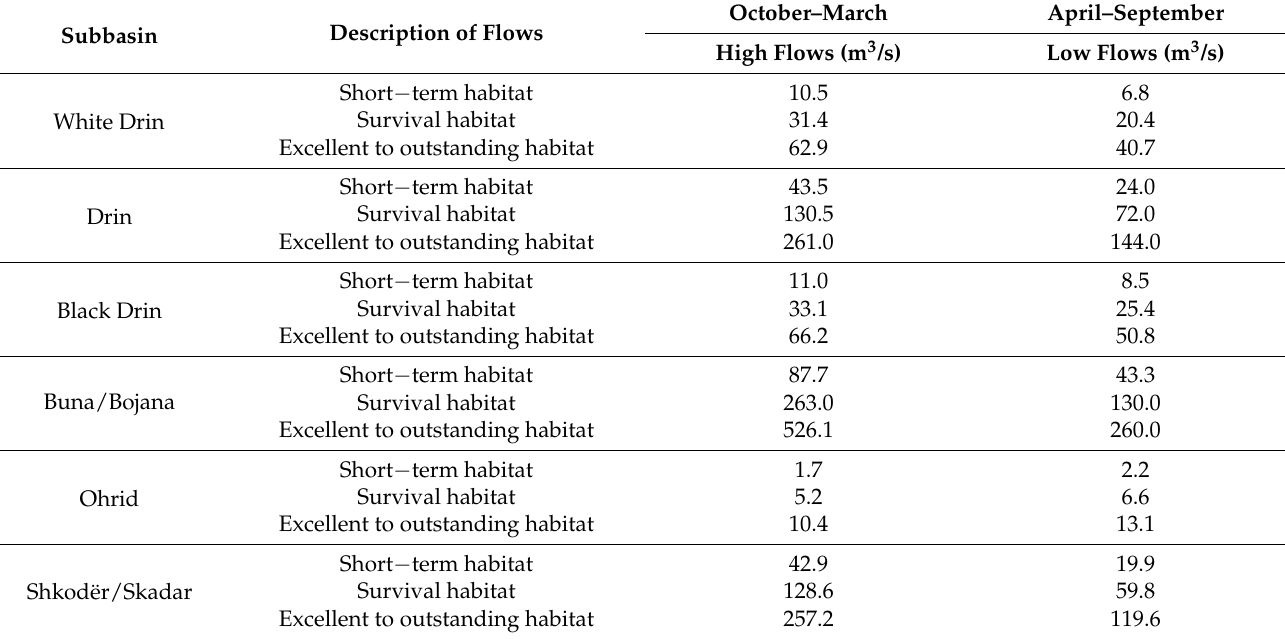
Table 4. Environmental minimum flow thresholds according to the hydrological approach (Tennant method). Subbasin